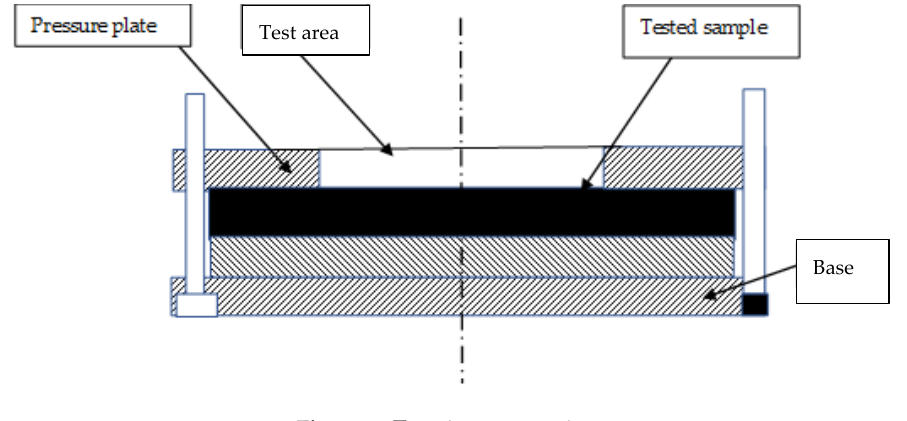
Figure 3. Test rig cross-section .